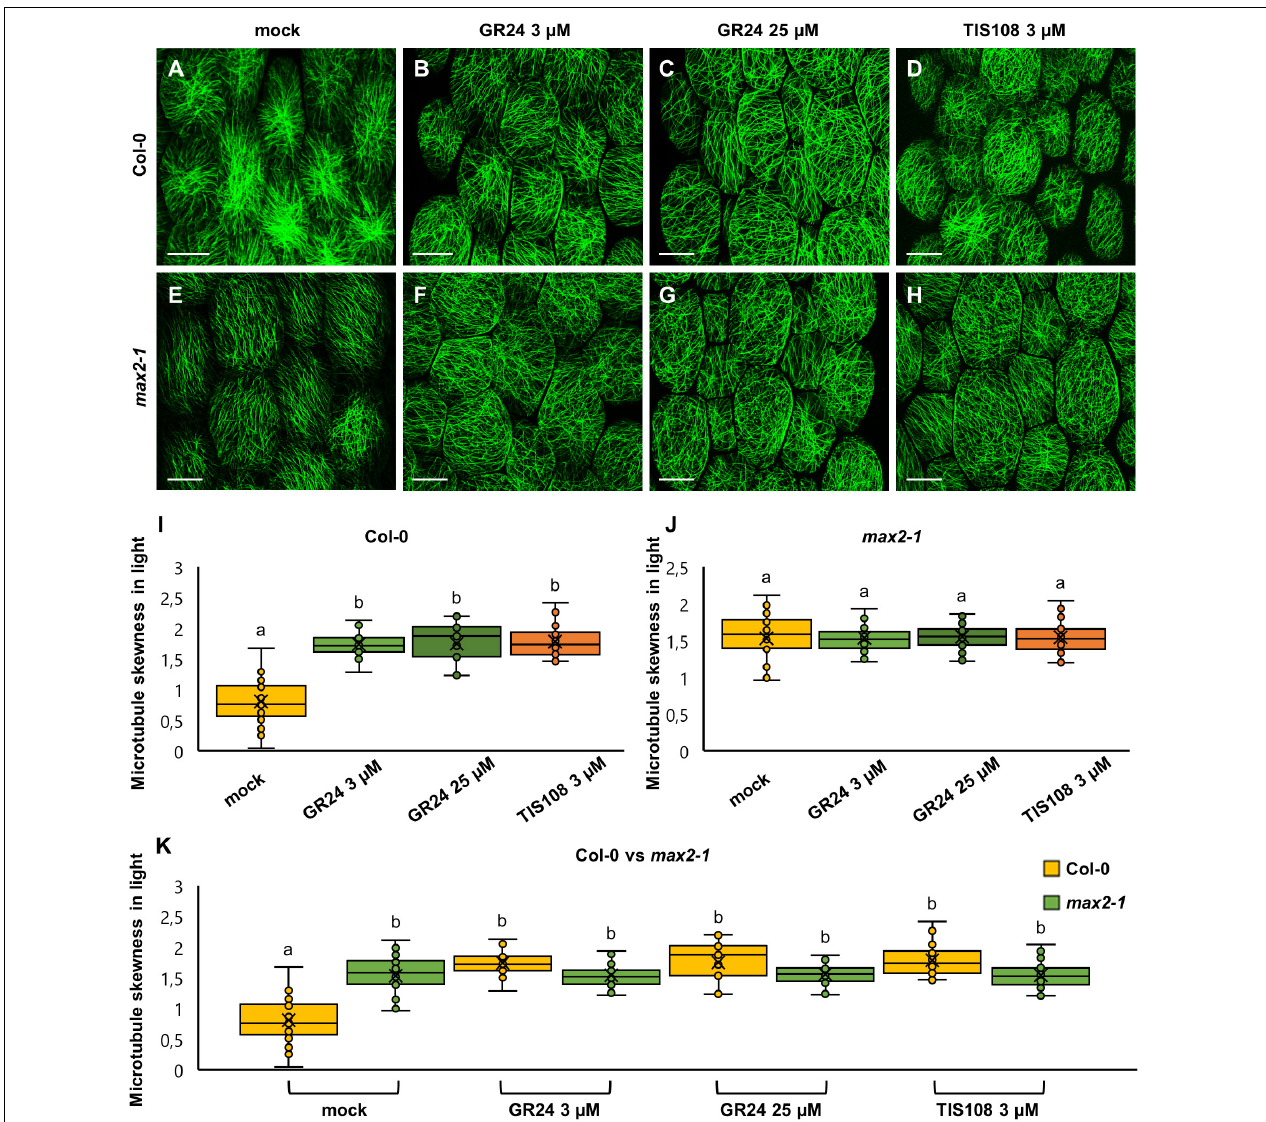
FIGURE 5 | The skewness of fluorescence distribution of GFP-MBD-labeled microtubules of light-grown Arabidopsis Col-0 and max2-1 epidermal hypocotyl cells in the presence or absence of the synthetic strigolactone GR24 (3 µ M and 25 µ M) or the biosynthetic inhibitor of strigolactone production TIS108 (3 µ M). (A–D) Overviews of hypocotyl of Col-0 seedlings treated with mock (A) , 3 µ M GR24 (B) , 25 µ M GR24 (C) , 3 µ M TIS108 (D) . (E–H) Overview of hypocotyl of max2-1 seedlings treated with mock (E) , 3 µ M GR24 (F) , 25 µ M GR24 (G) , 3 µ M TIS108 (H) . (I,J) Quantitative assessment of fluorescence distribution skewness, comparing Col-0 [ (I) ; N ≥ 17; Welch’s ANOVA was followed with Scheffé’s test; the statistical comparison is shown within groups sharing the same genotype; letters in the graph are shared by groups without statistically significant differences at the 0.01 probability level; results are in Supplementary Table 7 ] and max2-1 [ (J) ; N ≥ 34; Welch’s ANOVA showed no statistically significant difference within the dataset; F (3, 161) = 0.0777, p = 0.9719]. (K) Collective quantification of fluorescence skewness comparing Col-0 and max2-1 in a pairwise manner in all experimental conditions ( N ≥ 17; two-way ANOVA was followed with Scheffé’s test; a statistical comparison is shown within groups sharing the same genotype; letters in the graph are shared by groups without statistically significant differences at the 0.001 probability level; results are in Supplementary Table 8 ). In all box plots, the average is presented by × , median by the middle line, 1 st quartile by the bottom line, 3 rd quartile by the top line; the whiskers lie within the 1.5 × interquartile range (defined from the 1 st to the 3 rd quartiles) while outliers are omitted. Scale bars: 20 µ